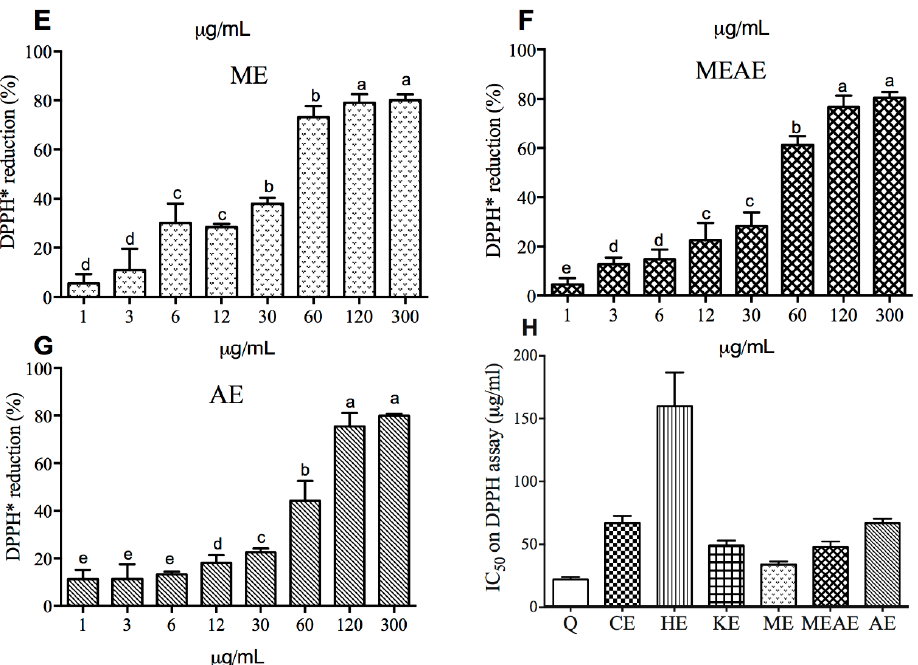
Figure 1. Scavenging capacity of the DPPH • radical ( A – G ) and inhibitory concentration 50% (IC 50 ) values ( H ) of different extracts from Acacia farnesiana pods. The data are the mean with the standard deviation of three independent repetitions. CE = chloroformic extract; HE = hexanic extract; KE = ketonic extract; ME = methanolic extract; MEAE = methanolic:aqueous extract and AE = aqueous extract; Q = quercetin. a,b,c,d,e Different letters showed significant difference ( p < 0.05) in the same extract at different concentrations (Kruskal–Wallis test).